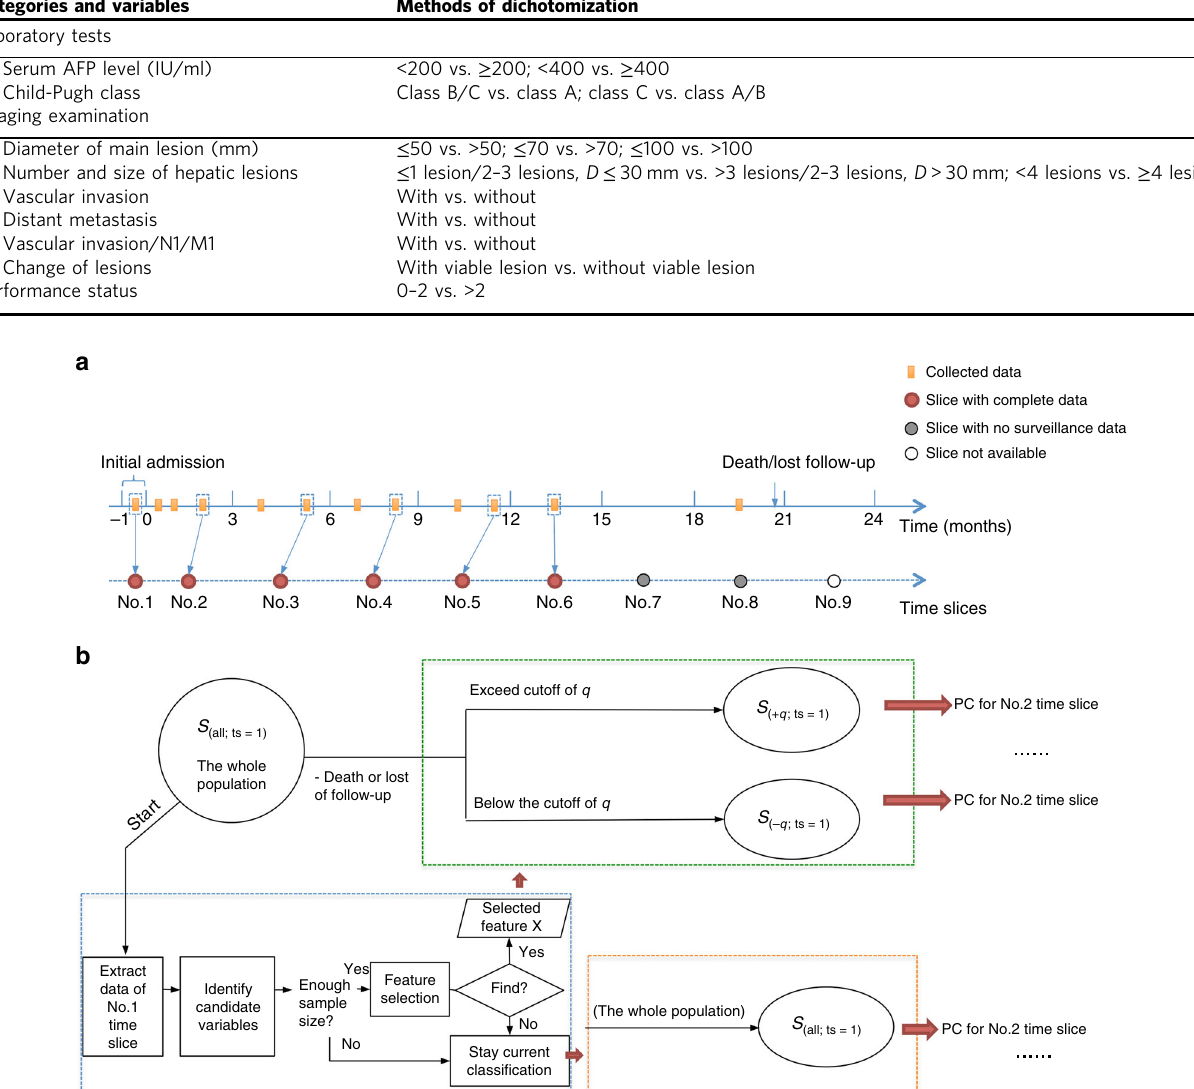
Table 6 Variables and methods of dichotomization for construction of the survival paths Categories and variables